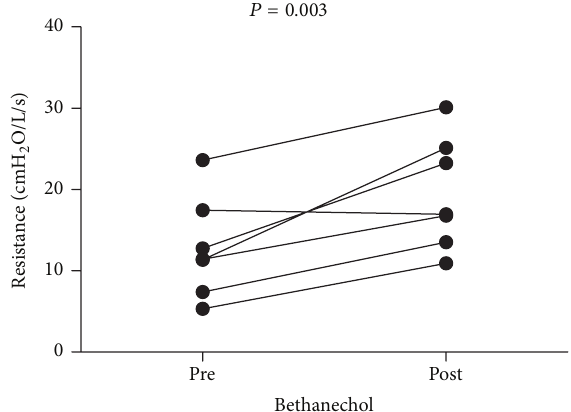
Figure 2: Plots of mean values for dynamic pulmonary resistance (resistance) before (pre) and after (post) bethanechol for each piglet. 𝑃 = 0.003 , paired 𝑡 -test one tailed. Figure 4: Plots of mean ( ± SEM) values for respiratory resistance ) , as a function of oscillatory frequency, before (pre) and after (𝑅 rs (post) bethanechol (𝑛 = 7) . As shown, significant differences in 𝑃 = 0.018 the middle oscillatory frequencies range are displayed ( ∗ 𝑃 < 0.05) ; paired 𝑡 -test one tailed at each frequency and overall (𝑃 = 0.0002)